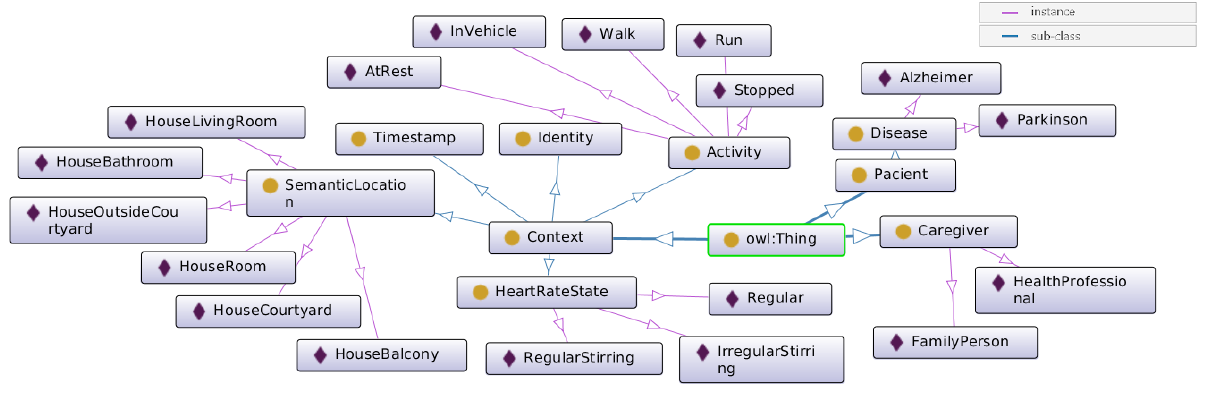
Figure 3. Context Ontology for Alzheimer’s